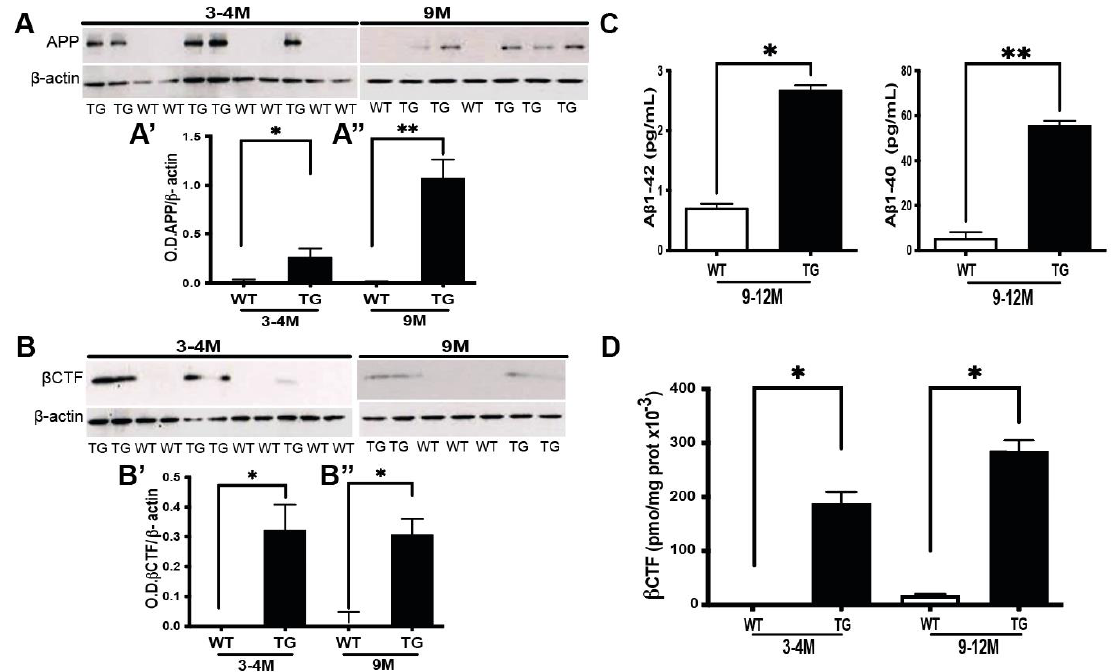
Figure 1. APP and its cleavage product expression in pre-symptomatic APP/PS1 mouse retina. ( A ) Representative western blot images of APP expression (apparent Mw = 98 kDa), as revealed with 6E10 antibody directed against the human APP transgene and quantified after normalization over β -actin, used as a loading control. ( A’ ) Relative quantification of APP expression (WT n = 6: 3M+3F; TG = 5: 3M+2F) for 3–4 months) and ( A” ) WT n = 6: 3M+3F); TG = 4: 2M+2F for 9 months). ( B ) Representative western blot images of β CTF expression (apparent Mw = 14 kDa), as revealed with CT20 antibody directed against the cleavage products of human APP. ( B’ ) relevant quantification (WT n = 4: 3M+1F; TG = 5: 3M+2F for 3–4 months) and ( B ’’) WT n = 5: 3M+2F; TG = 5: 3M+2F for 9 months). ( C ) A β expression was quantified by ELISA against human A β 1-40 (WT n = 3: 2M+1F and TG n = 8 6M+2F p = 0.004) with all mice aged 12 months and A β 1-42 proteins (WT n = 3: 2M+1F and TG n = 8: 6M+2F; p = 0,01) with all mice aged 12 months. ( D ) ELISA quantification of β CTF (WT n = 4: 2M+2F; TG = 3: 2M+1F for 3–4 months and WT n = 3: 2M+1F; TG = 4: 2M+1F for 9 m and 1F for 12mo). WT = non-transgenic, wild-type; TG = transgenic APP/PS1. * p < 0.05; ** p <